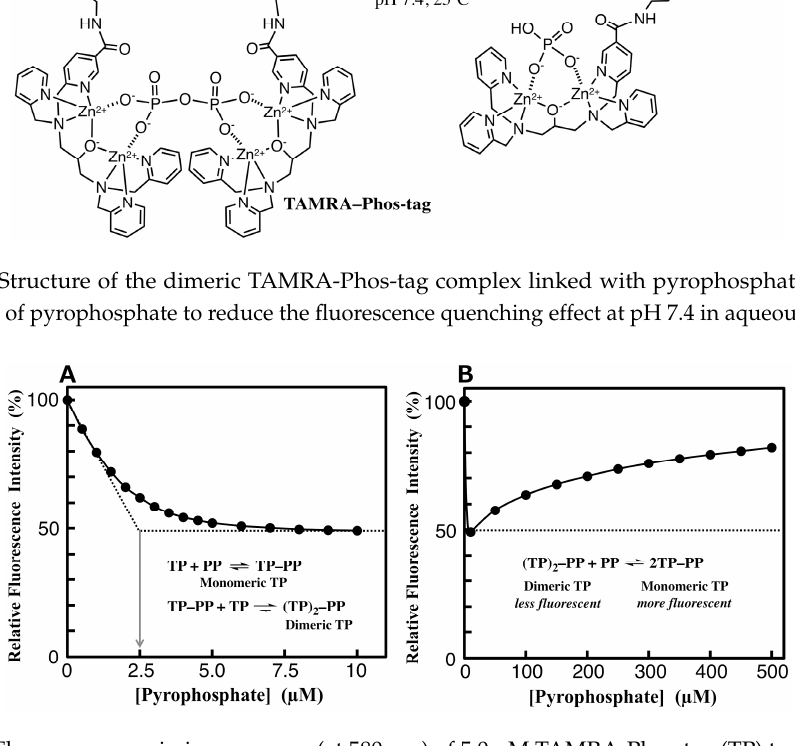
Figure 6. Fluorescence emission response (at 580 nm) of 5.0 µM TAMRA-Phos-tag (TP) to increasing level of pyrophosphate (PP) at pH 7.4 (10 mM Hepes-NaOH, 0.10 M NaCl) and 25 °C. The concentration ranges of pyrophosphate are 0–10 µM for ( A ) and 0–500 µM for ( B ).